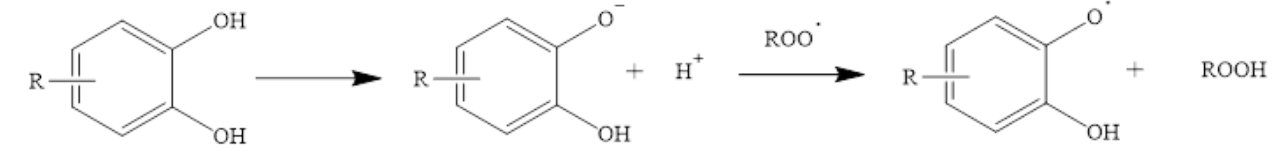
Figure 5. Phenolic acid derivative neutralizing a free radical via SPLET [53].